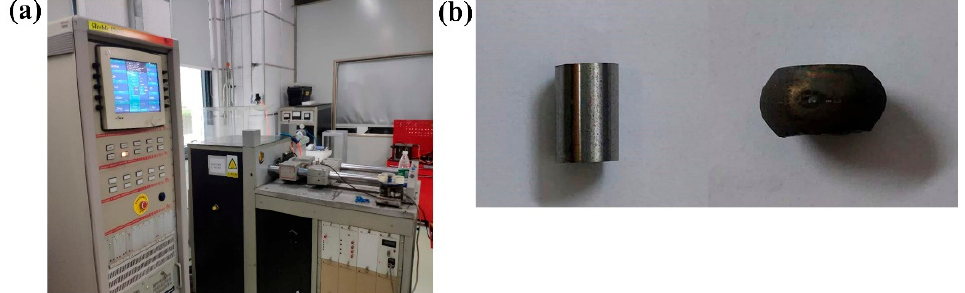
Figure 2. ( a ) Images of the thermal simulator Gleeble-1500 and ( b ) a small cylinder before and after compression.